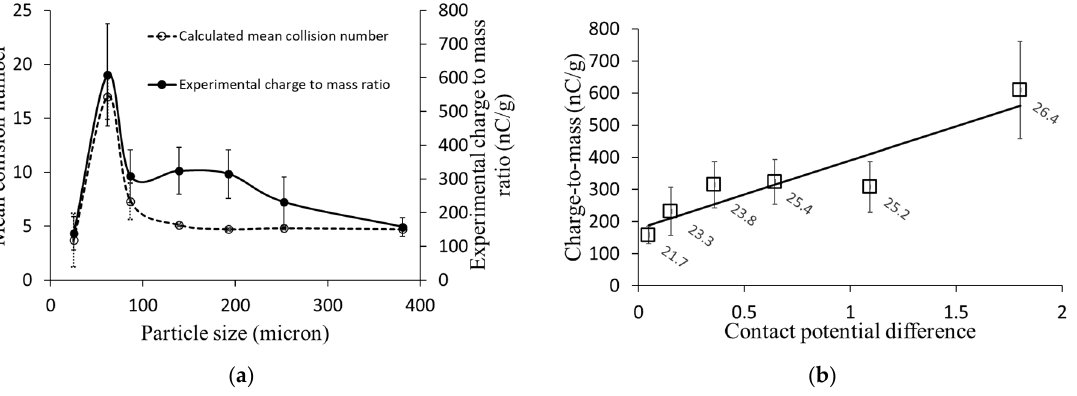
Figure 9. ( a ) Effect of particle size on mean collision number and charge-to-mass ratio; ( b ) correlation of experimentally measured charge-to-mass ratios with calculated contact potential difference for sieved samples with different particle sizes and different protein content percentages (data labels). Error bars show the deviation of charge measurements during multiple experimental runs.